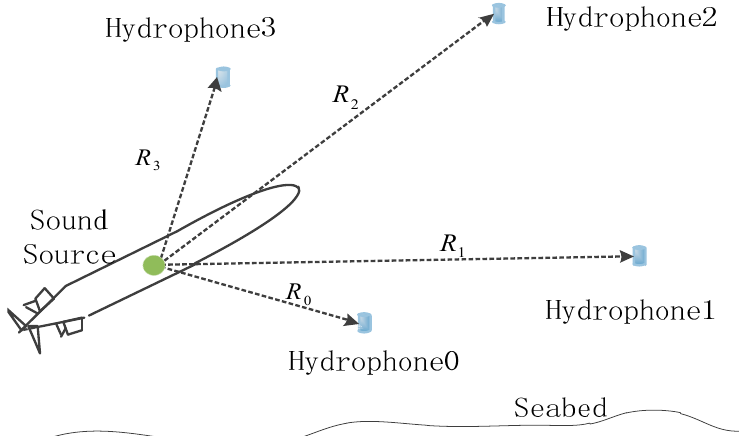
Figure 1 . Structure of LBL (Long Base Line) system. Figure 1. Structure of LBL (Long Base Line)